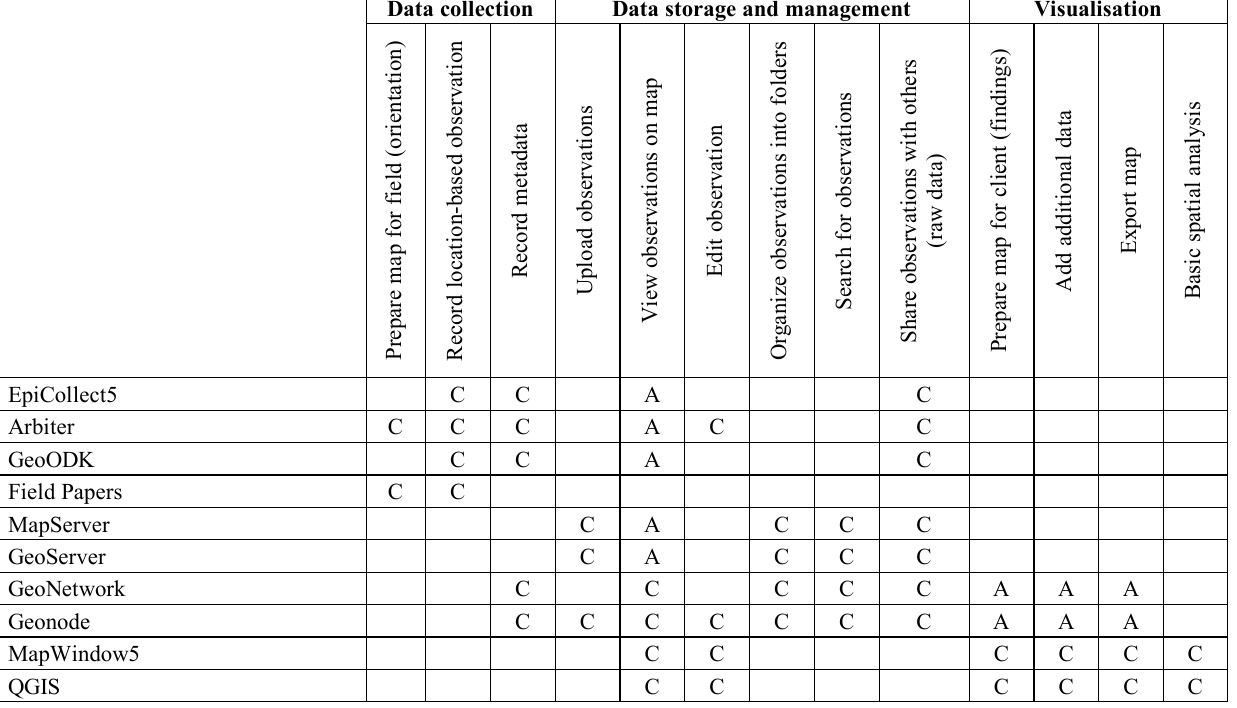
Table 1. Evaluation of functional